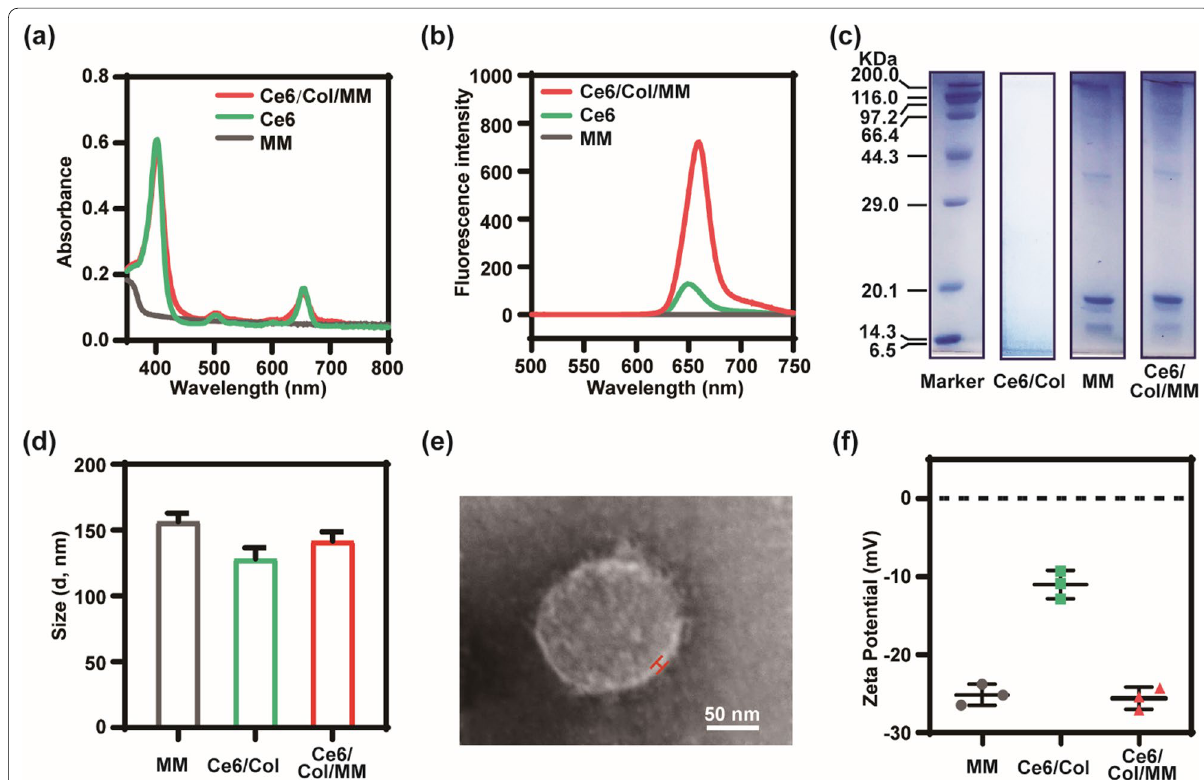
Fig. 1 Characterizations of Ce6/Col/MM. a Visible and b fluorescence spectra of MM, Ce6 (8 μg mL − 1 ) and Ce6/Col/MM (excited at 400 nm). c The protein composition of Ce6/Col, MM and Ce6/Col/MM by SDS-PAGE analysis. d Hydrodynamic diameter of MM, Ce6/Col and Ce6/Col/MM. e TEM image of Ce6/Col/MM, red line indicated the thickness of MM on the surface of Ce6/Col/MM. f Plot showing the zeta potentials of MM, Ce6/Col and Ce6/Col/MM. Data are shown as mean S.D. (n ± =